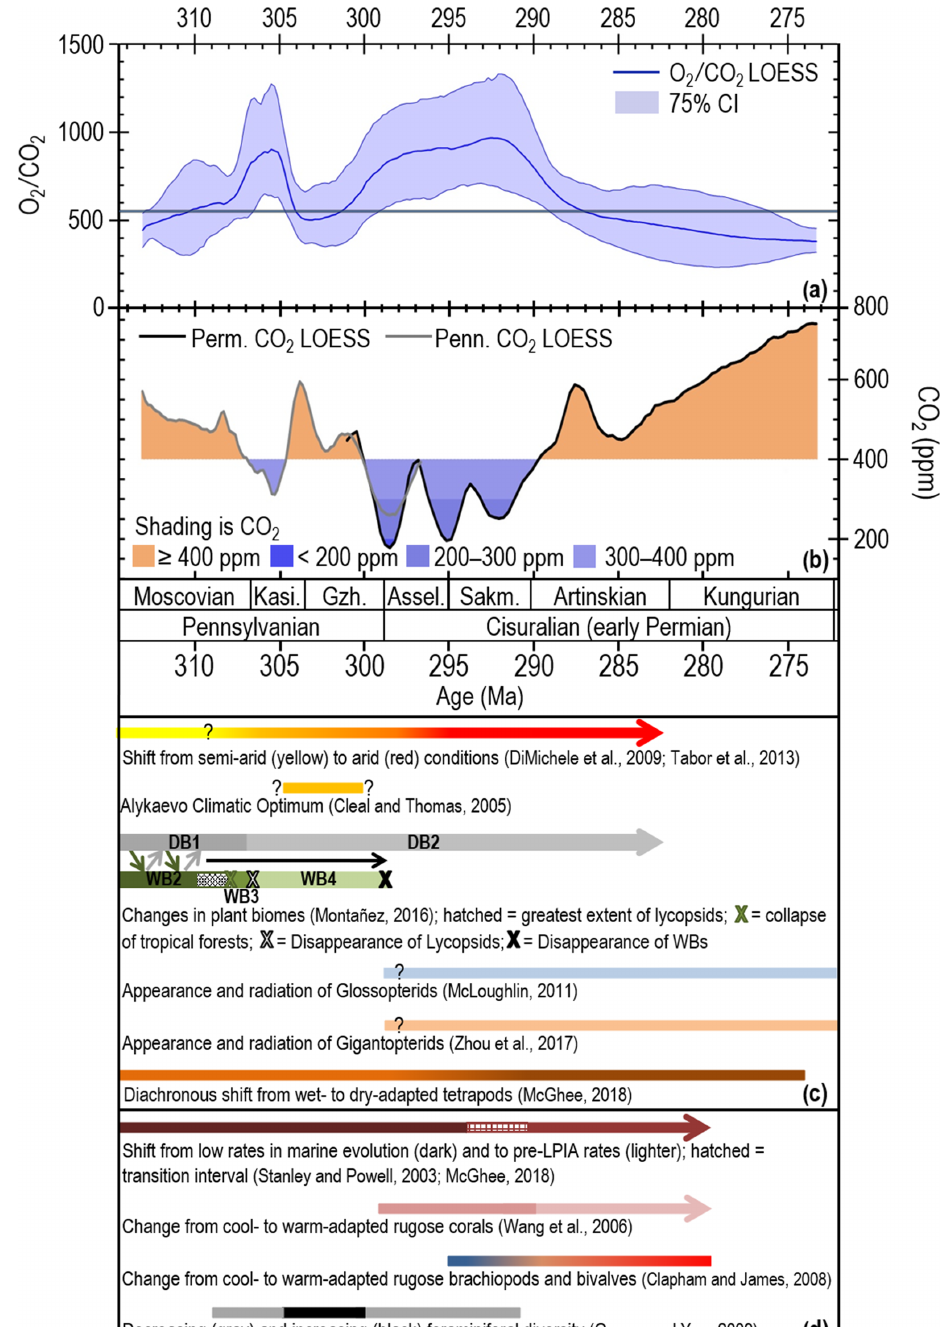
Figure 3. Late Paleozoic O 2 / CO 2 ratios and p CO 2 , as well as a comparison to environmental and biotic events. (a) O 2 / CO 2 estimates made using CO 2 values of this study and averaged time-equivalent modeled O 2 (Krause et al., 2018; Lenton et al., 2018). Trend line is the median of 1000 bootstrapped LOESS analyses; gray horizontal line is present-day O 2 / CO 2 . (b) Bootstrapped Pennsylvanian and Permian LOESS analyses (from Fig. 2a), with significant overlap across the Pennsylvanian–Permian boundary interval. The shading indicates CO 2 above (orange) and below (shades of blue) the mean value for the 16 × 10 6 -year record through the late Pennsylvanian reported in Montañez et al. (2016). Temporal changes in terrestrial (c) and marine (d) ecosystems. Plant biomes from Montañez (2016): wetland biome (WB) 2 (i.e., cordaitalean/lycopsid co-dominance), WB 3 (i.e., lycopsid dominated with cordaitaleans decreasing and tree ferns increasing in occurance and prominence), WB 4 (i.e., tree fern dominated), dryland biome (DB) 1 (i.e., cordaitalean dominated), DB 2 (i.e., walchian dominated). Diagonal arrows indicate 10 5 -year glacial–interglacial shifts between wet- and dry-adapted